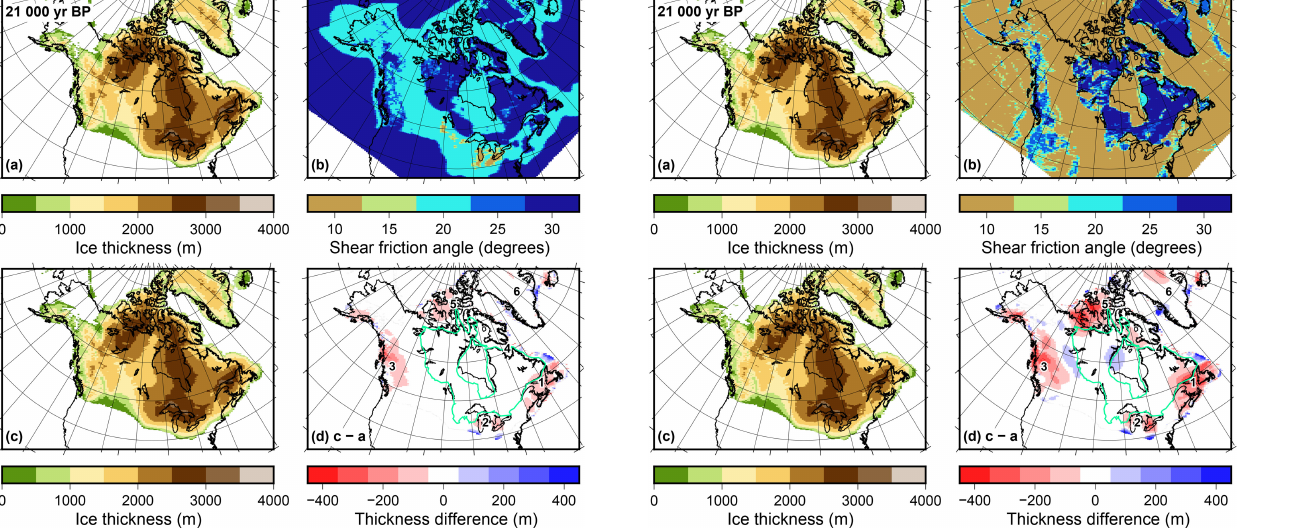
Figure 9. Impact of the grain size of sediments on the simula- tion of North American ice sheets. (a) Thickness of the ice sheets at 21000yrBP (after about 101000 years of simulation) with the default shear friction angle, φ = 30 ◦ . (b) Shear friction angle ad- justed downwards for finer-grained sediments. (c) Ice thickness at 21000yrBP using the shear friction angle shown in (b) . (d) Differ- ence in ice thickness between (a) and (c) . The numbers in (d) rep- resent areas mentioned in the text: (1) eastern Canada, (2) Great Lakes, (3) Cordillera, (4) Hudson Strait, (5) Arctic Archipelago and (6) Greenland. The green outline shows the exposed limit of the Canadian Shield.